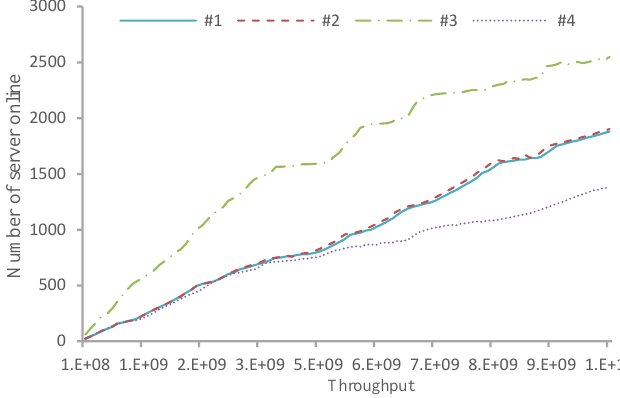
Figure 8. Number of servers online in different data centers.